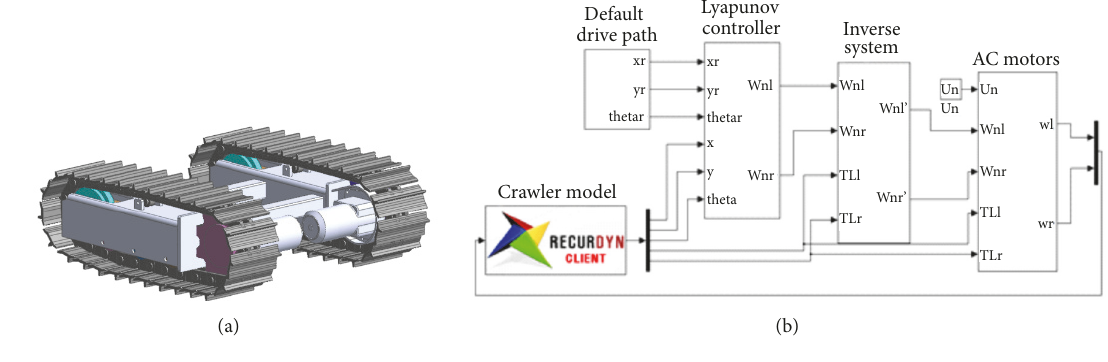
Figure 8: Virtual prototype model of the